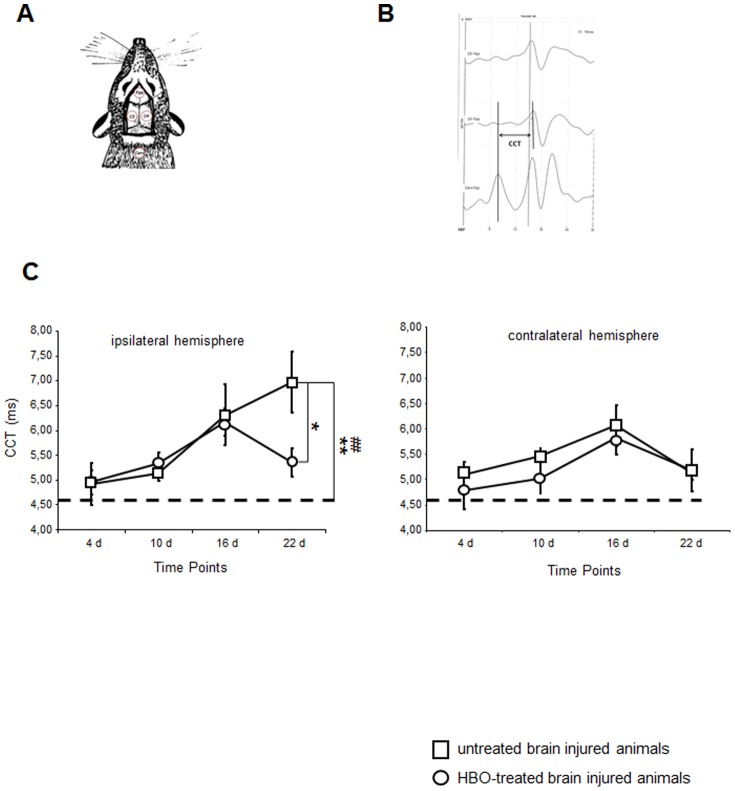
Time-dependent changes in the central conduction times following traumatic brain injury and HBO treatment established by somatosensory-evoked potentials.A. Schematic representation of the somatosensory-evoked potential recording sites adapted from the human 10–20 system. B. The central conduction time (CCT) is calculated by subtracting the peak latency of the major response from the neck from the latency of the primary cortical response C. Time-dependent modulation in the central conduction time recorded at the ipsi- and contralateral hemisphere in treated and untreated brain injured rats. Open square: HBO-treated brain injured rats; open circle: untreated brain injured rats; ---- baseline recordings; The HBOT effect was not observed at all time points (repeated measures mixed model ANOVA; F(1,20) = 0.38, n.s.); however, there was a significant effect at 3 weeks. *p<0.05 (repeated measures ANOVA, Bonferonni corrected); #
p≤0.003 (t-test), HBO-treated versus untreated injured animals. ##
p<0.001 (ANOVA), HBO-treated animals versus sham controls; n = 5 for untreated, n = 12 for HBO-treated (uneven group sizes arise from missing data points in some animals, which were excluded in repeated measures mixed model ANOVA). Error bars represent ± standard error means.